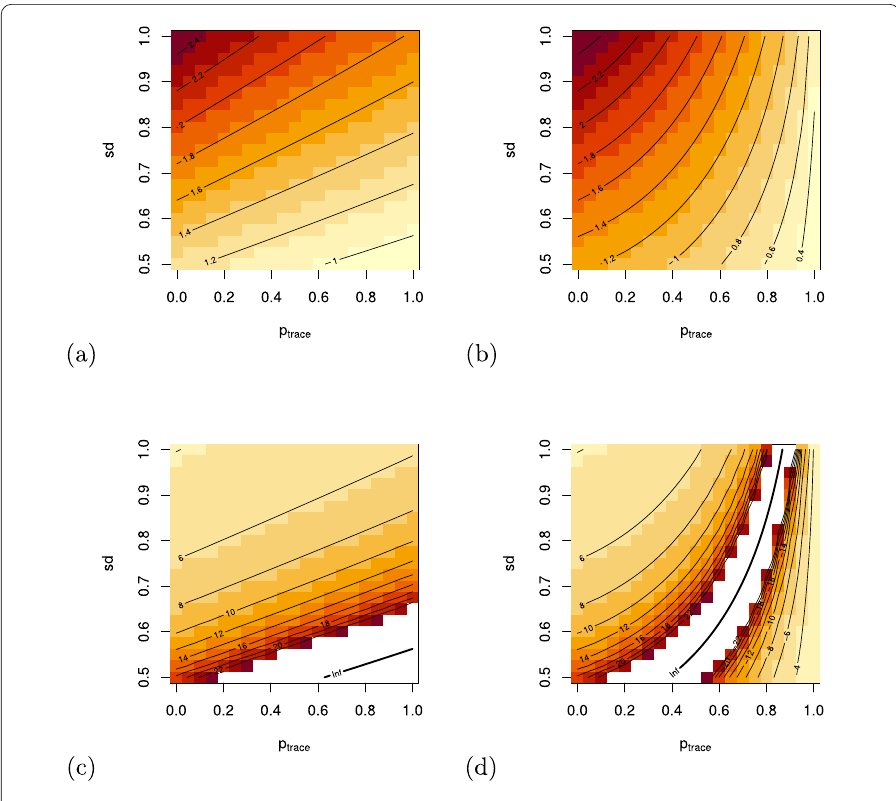
Figure 16 Influence of social distancing (reduction of the contact rate) and contact tracing on R e and T 2 . ( a ) and ( c ): One-step tracing, ( b ) and ( d ) recursive tracing. ( a ) and ( b ) R e , ( b ) and ( d ) T 2 . Note that in ( b ) and ( c ), there is a singularity for T 2 at the line R e = 1, where T 2 becomes